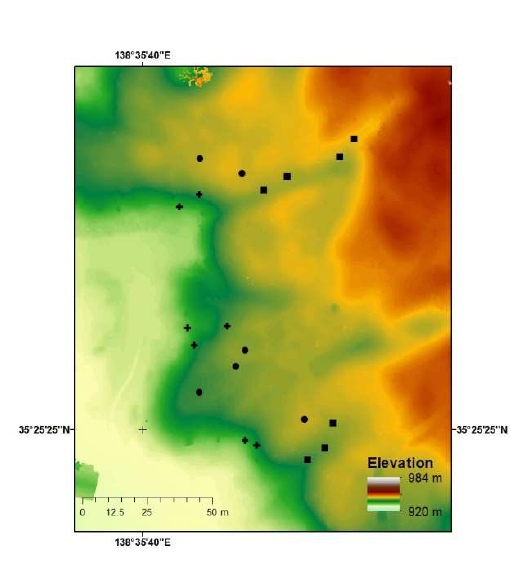
Figure 5. Location of the vegetation plots on the top of the hill (circle), slope (cross) and sunken place (rectangle).